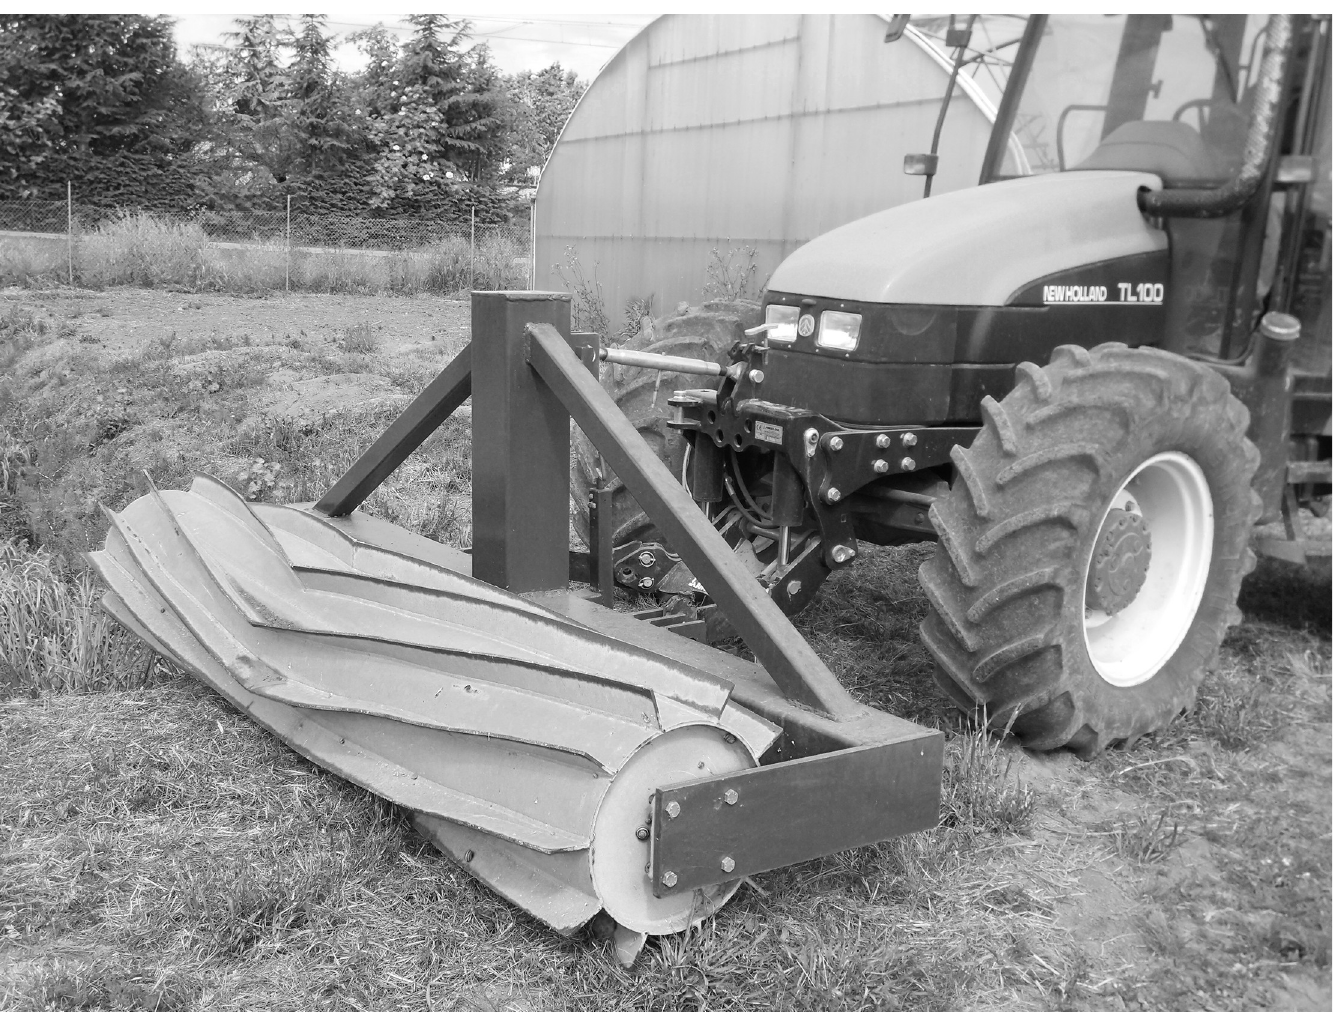
Fig 5. The Rodale Institute design-based roller crimper front-mounted at the New Holland TL100 tractor.